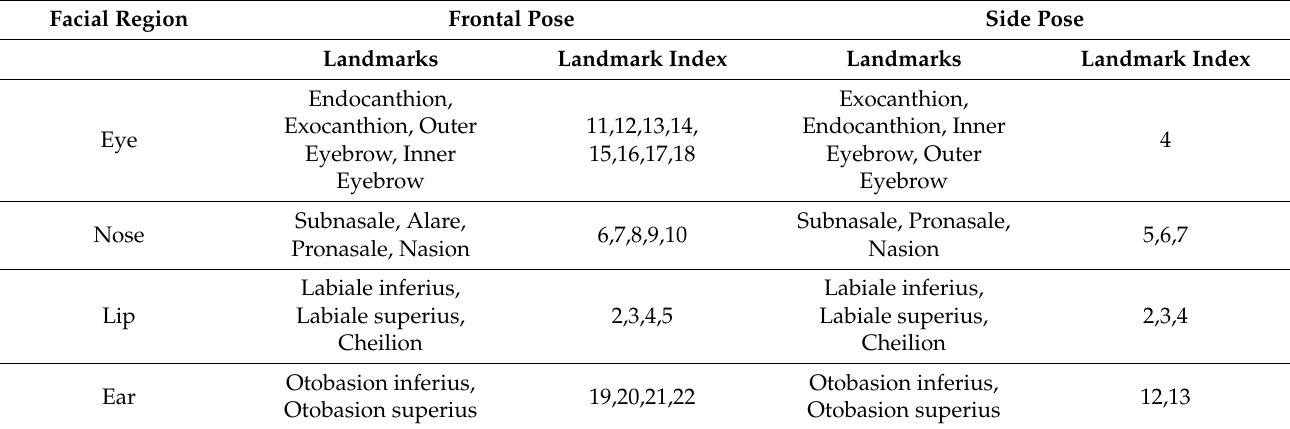
Table 4. Facial landmarks and index numbers of each facial region.